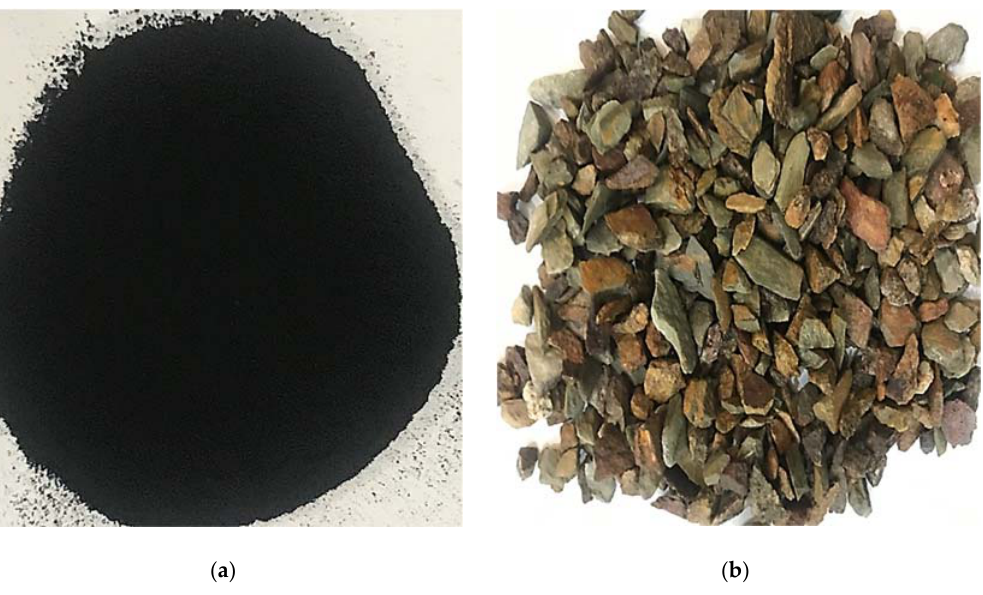
Figure 1. Materials used. ( a ) Recycled rubber waste; ( b ) Used aggregates. Table 2. Test matrix incorporating various proportions of recycled rubber waste.